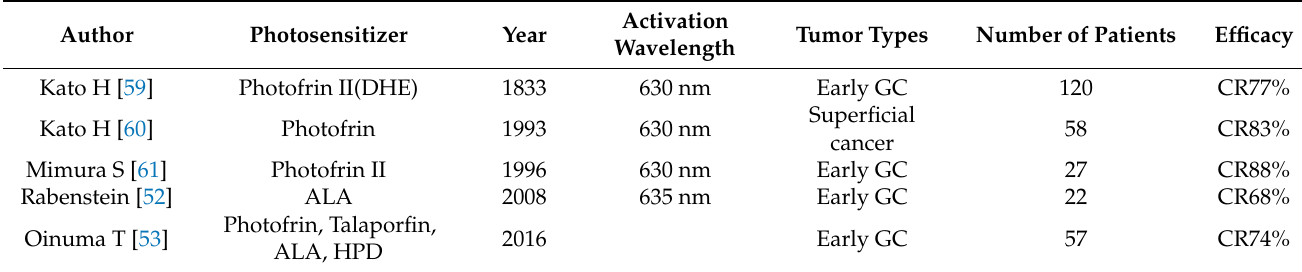
Table 4. Clinical study of PDT for